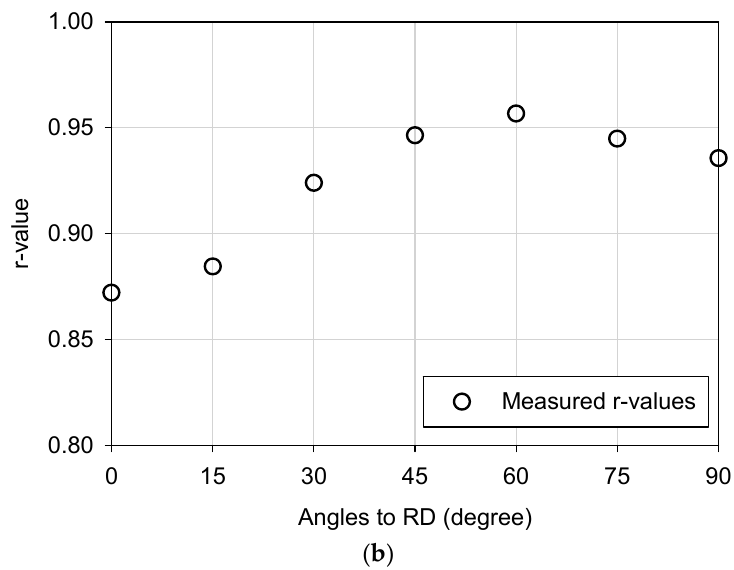
Figure 3. Measured r -values for the QP980 steel averaged from 5 experiments for each tensile direction: ( a ) evolutions with respect to plastic work; ( b ) averaged r -value distributions.